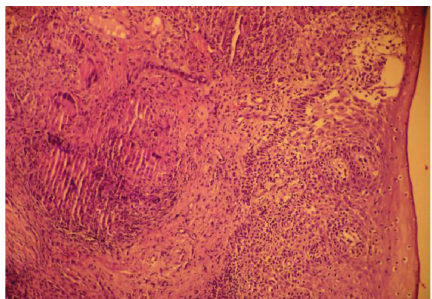
Figure 2: Section showing epithelioid cell granuloma with Lang- hans’ type of giant cells. (H & E; X10).